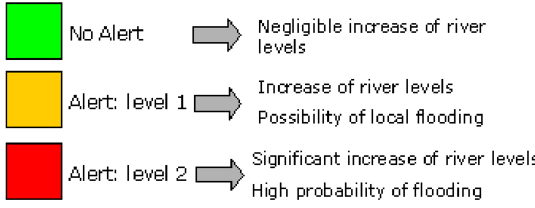
Fig. 1. Synthetic scheme of the alert levels in Liguria region and the related expected consequences.